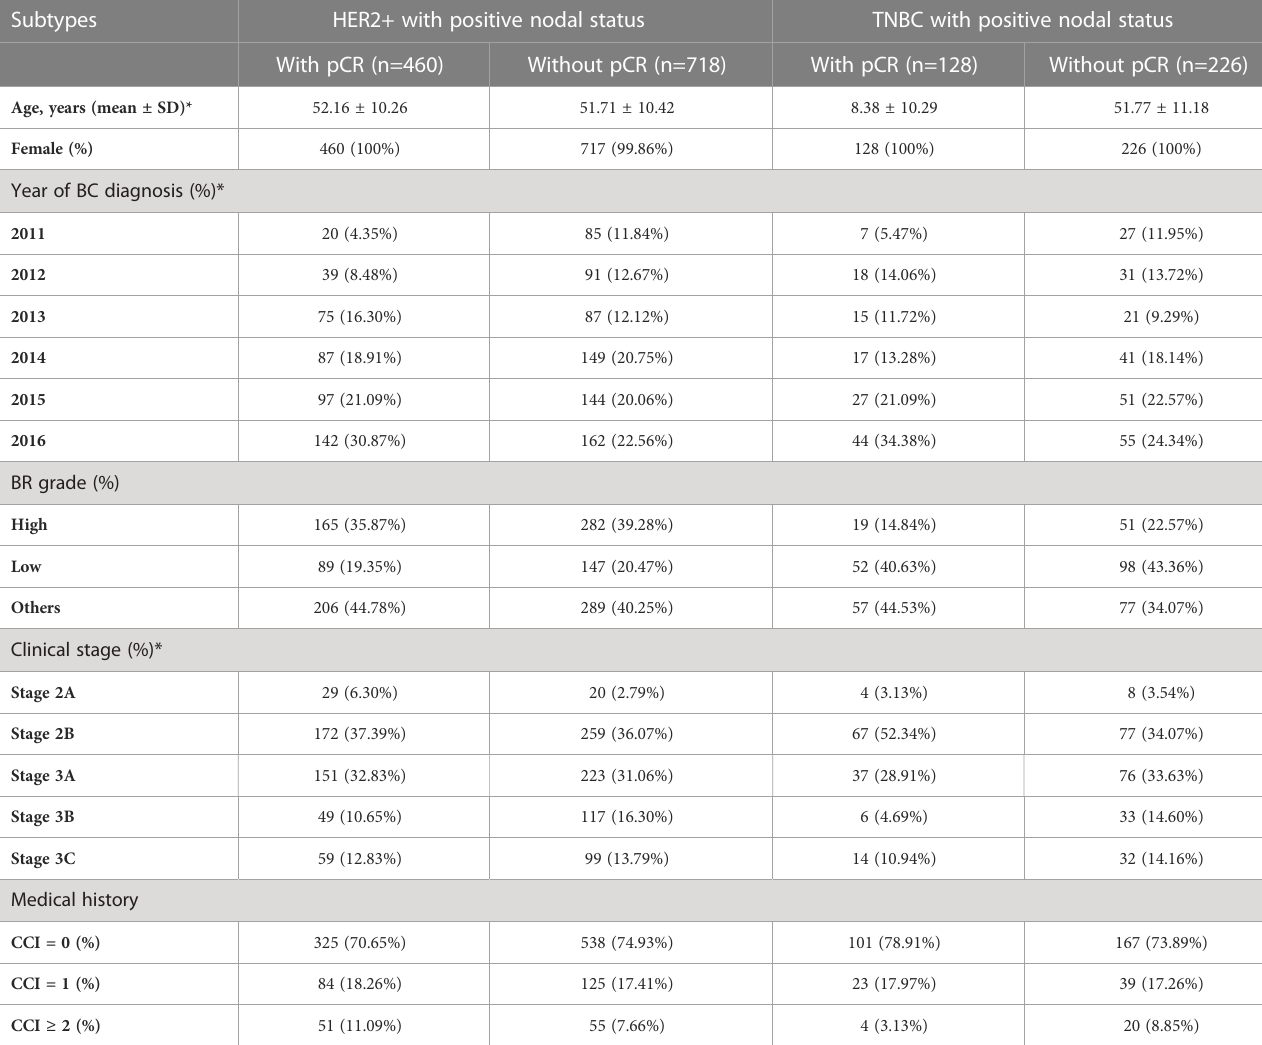
TABLE 1 Baseline patient characteristics strati fi ed by the subtype of BC and status of